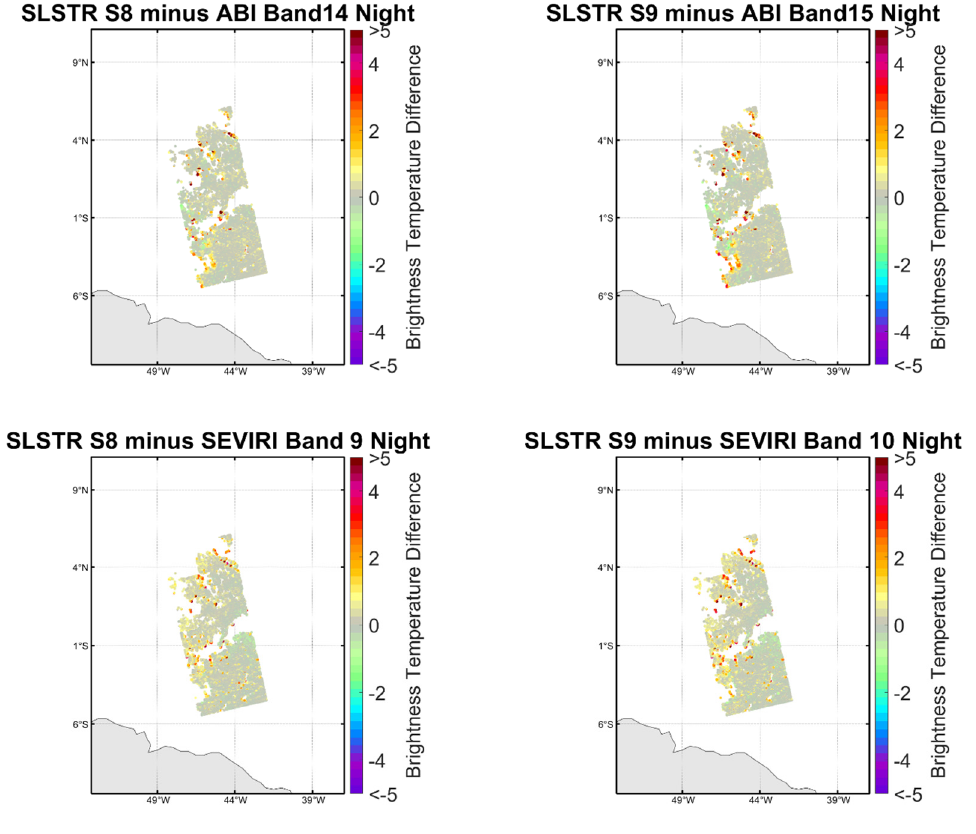
Figure 19. As shown in Figure 16, but for nighttime.